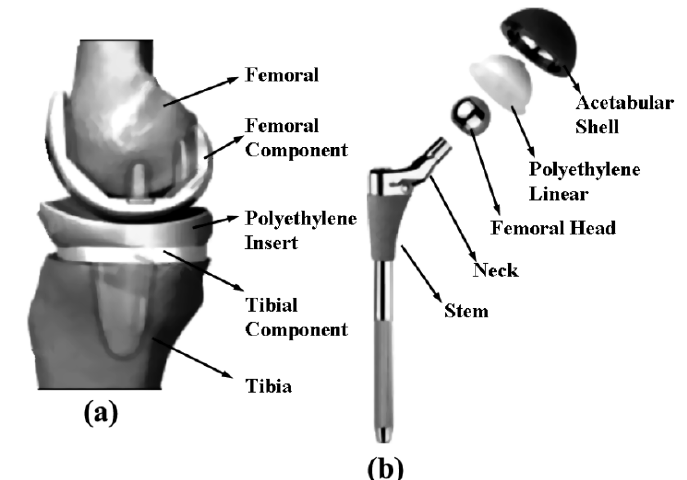
Figure 4. Titanium orthopedics medical devices: ( a ) Total knee replacement; ( b ) Total hip